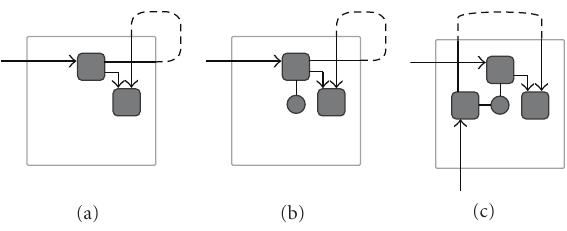
Figure 9: Three ways to properly order the two inputs to an LU: (a) introduce su ffi cient external delay, (b) supply both inputs from an LU within the same cell that participates in a join, and (c) supply the A -input from an LU that participates in a join with the LU that supplies the B